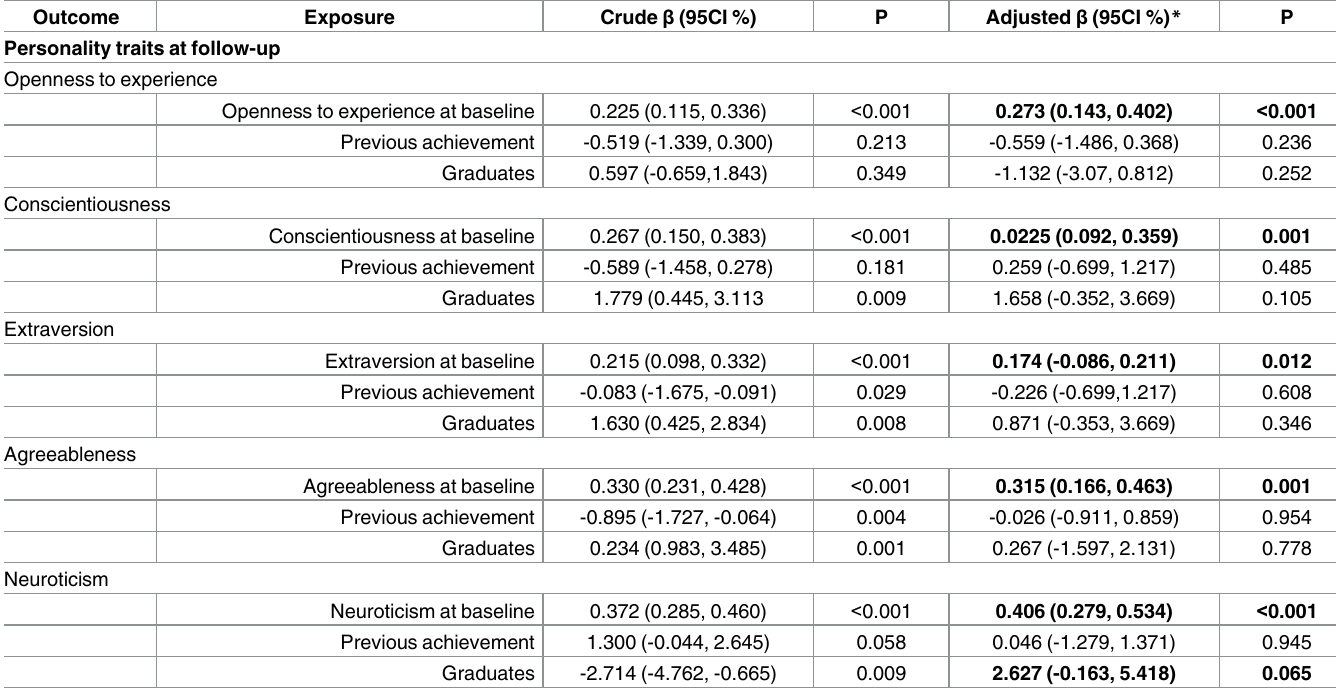
Table 2. Cross-lagged associations between personality traits and previous achievement at follow-up.